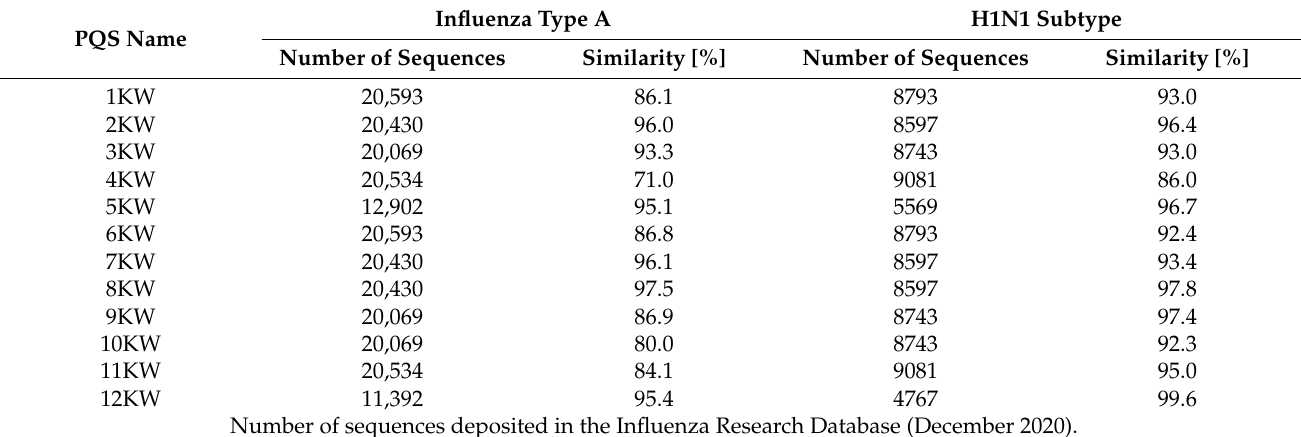
Table 2. Summary of the PQS motifs similarity within the influenza virus type A and H1N1 subtype